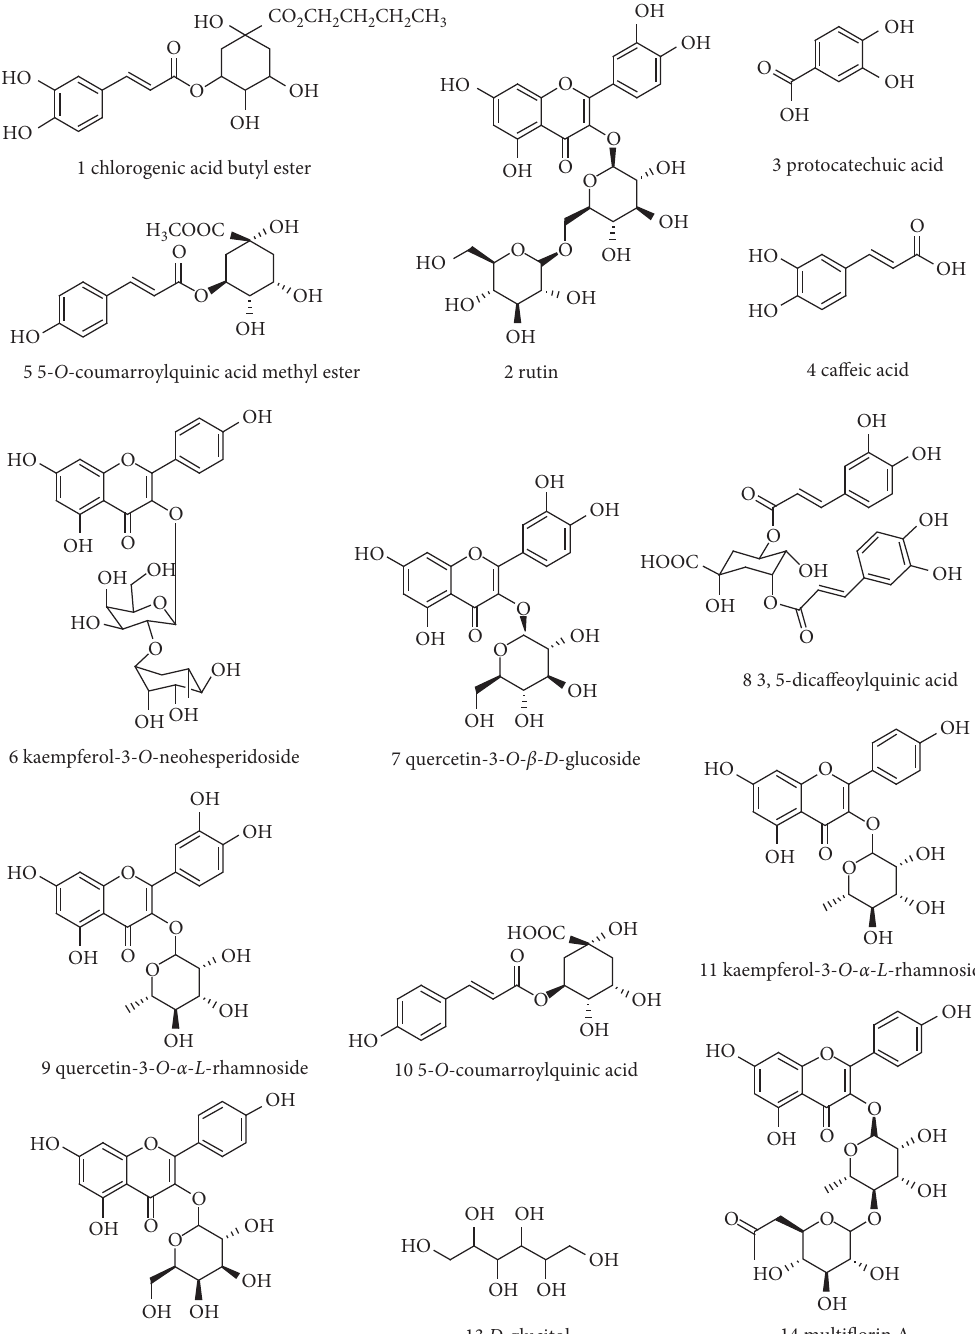
Figure 1: Chemical structures of compounds 1 – 14 isolated from A. persica